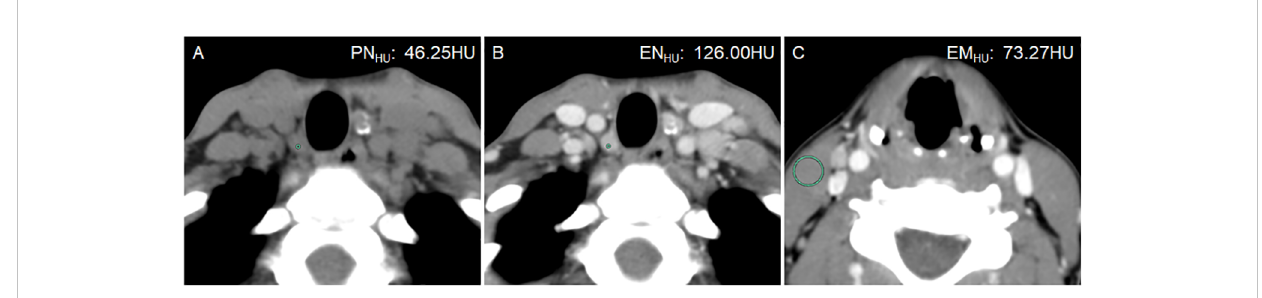
FIGURE 2 A 21-year-old woman with bilateral PTC. Postoperative pathology con fi rmed that all lymph nodes in the right level VI were metastasis-positive (5/5). (A) PN HU was 46.25 HU. (B) EN HU was 126 HU. (C) EM HU was 73.27 HU. EN-PN HU, EN/PN HU , EN-EM HU , and EN/EM HU were 79.75 HU, 2.72, 52.73 HU, and 1.72, respectively.